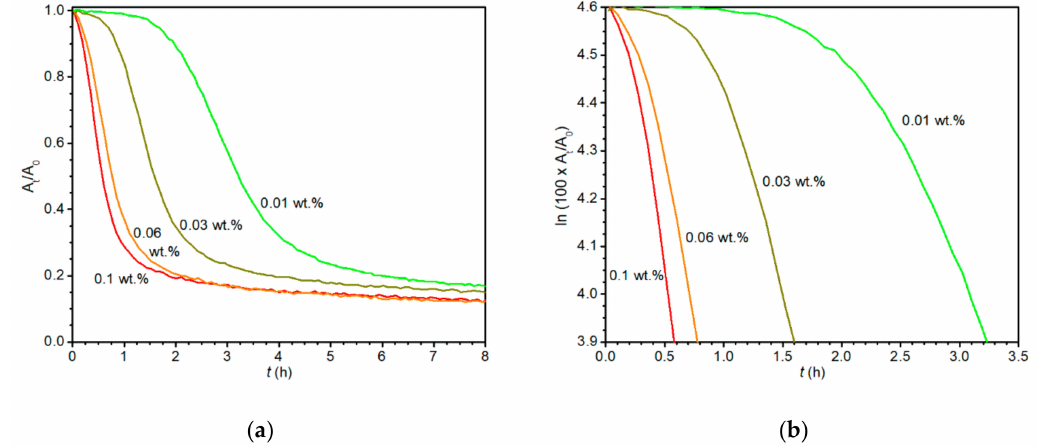
Figure 2. Time development of the infrared band ν a ( cis -C = C–H ) at 3008 cm − 1 attributed to non-conjugated double bond system: ( a ) Linear plot for S471 / Mn at di ff erent metal concentration; ( b ) logarithmic plot for S471 /